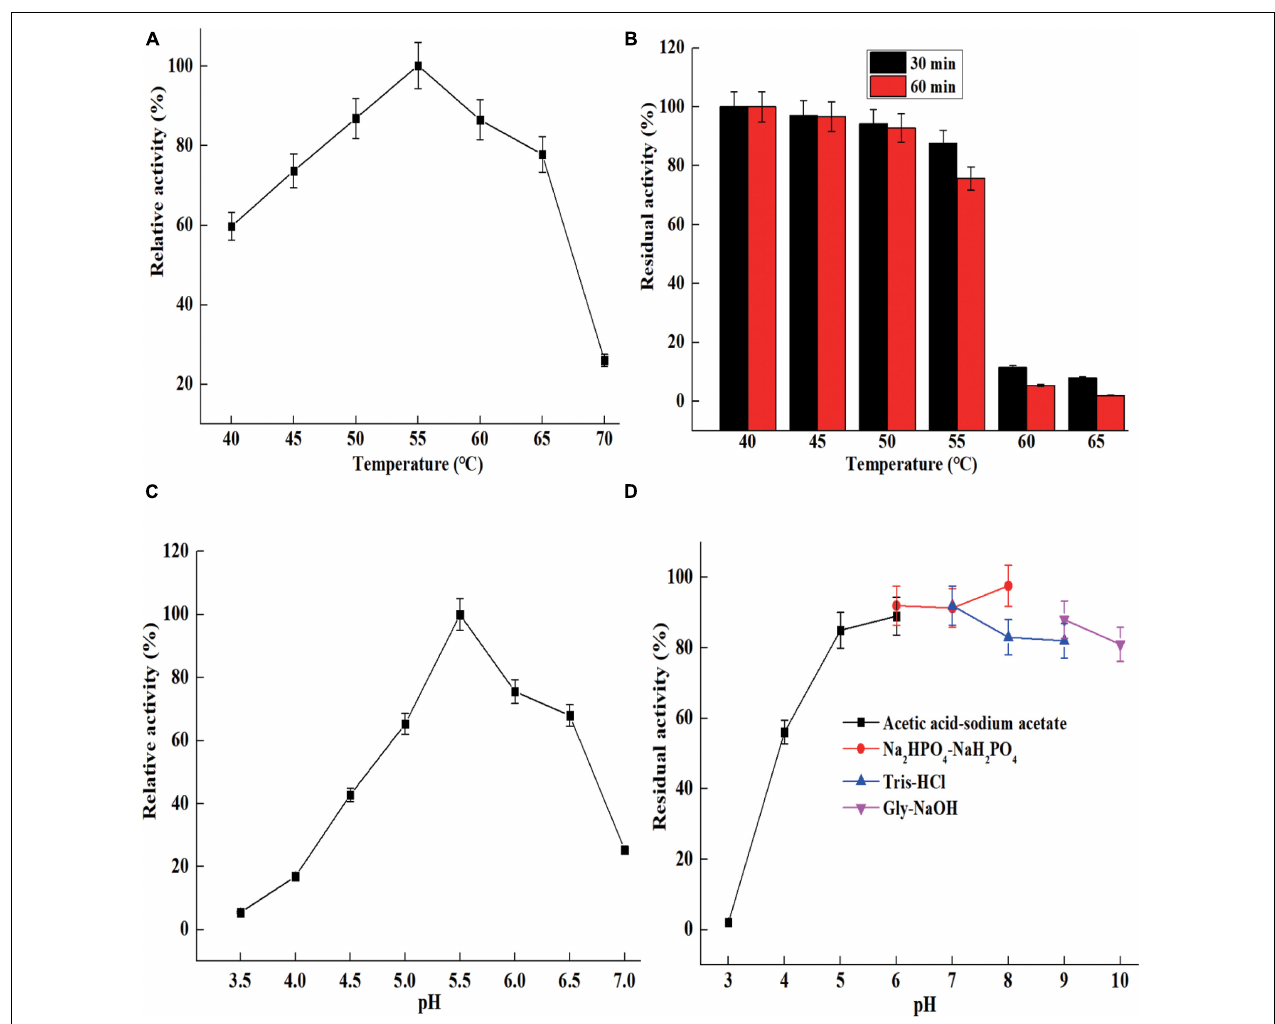
FIGURE 4 | The characterization of purified Sh Csn46. Optimum temperature (A) , thermal stability (B) , optimum pH (C) , and pH stability (D) .